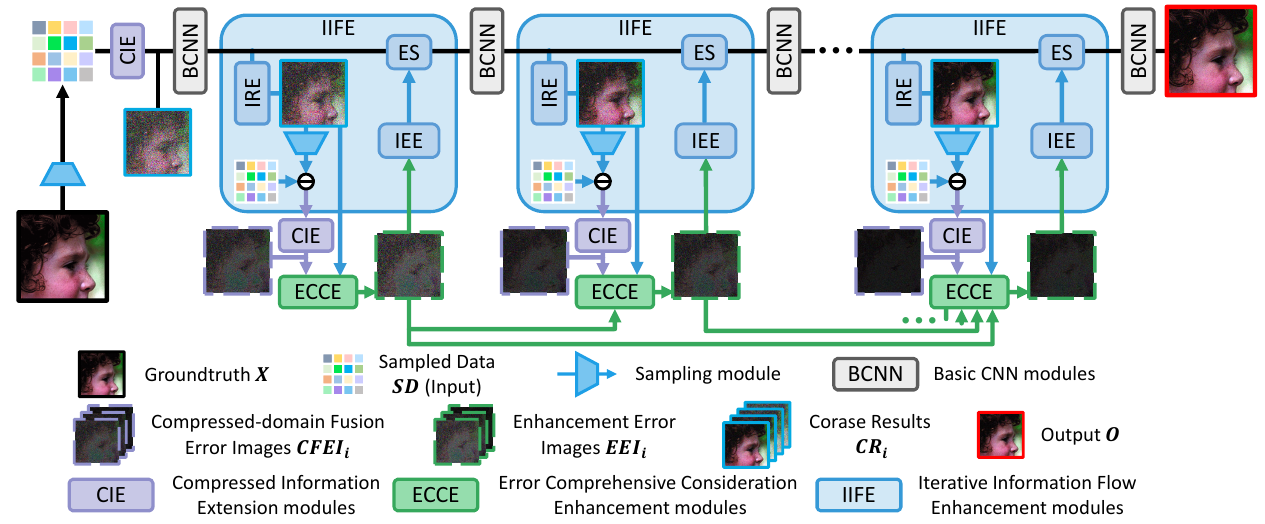
Figure 1. Overview of the proposed IEF-CSNET. The real image X to be sampled and the final output O are marked by solid black and red wireframes, respectively. X also plays the role of ground truth for training. (1) The CIE modules (displayed as purple blocks and introduced in Section 3.2)